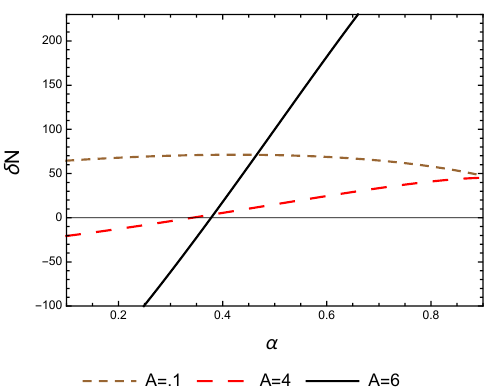
Figure 4 . Anti-parallelly accelerating detectors in (1 + 1) dimensions: δ N VS A = ∆ E A different fixed values of the coefficient α with ∆ E B